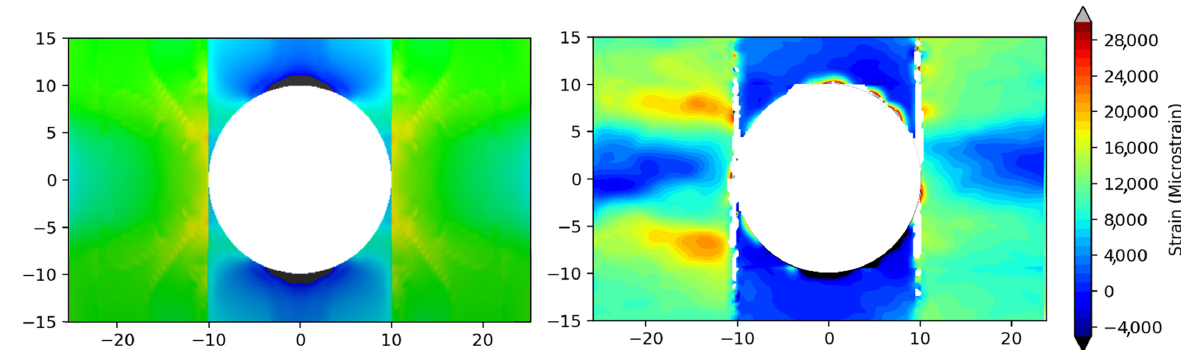
Figure 20. Hoop strain contour plot of FEA Model D at 80,000 cycles (left) compared to the experimentally measured strain